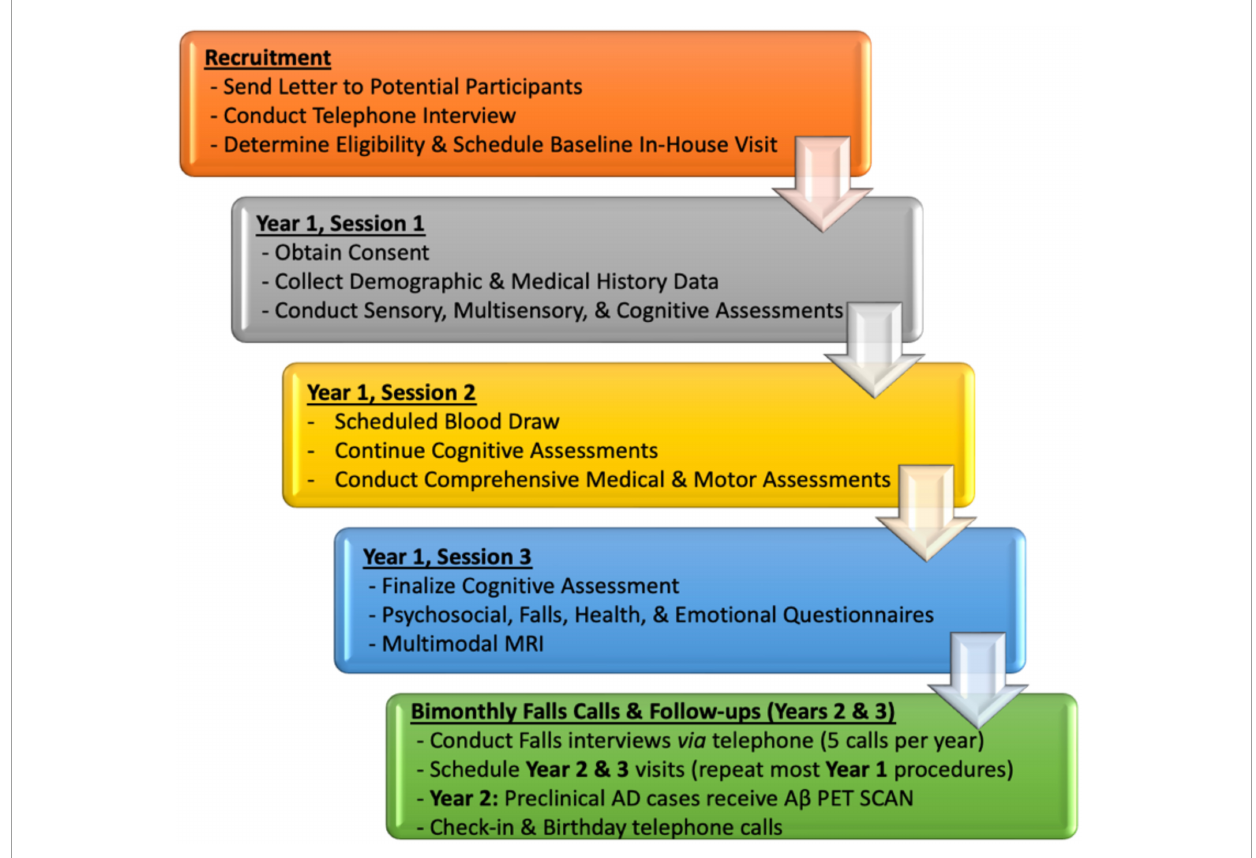
FIGURE3 VSI Study flow by Year with high-level overview of targeted domains by baseline (Year 1) and follow-up